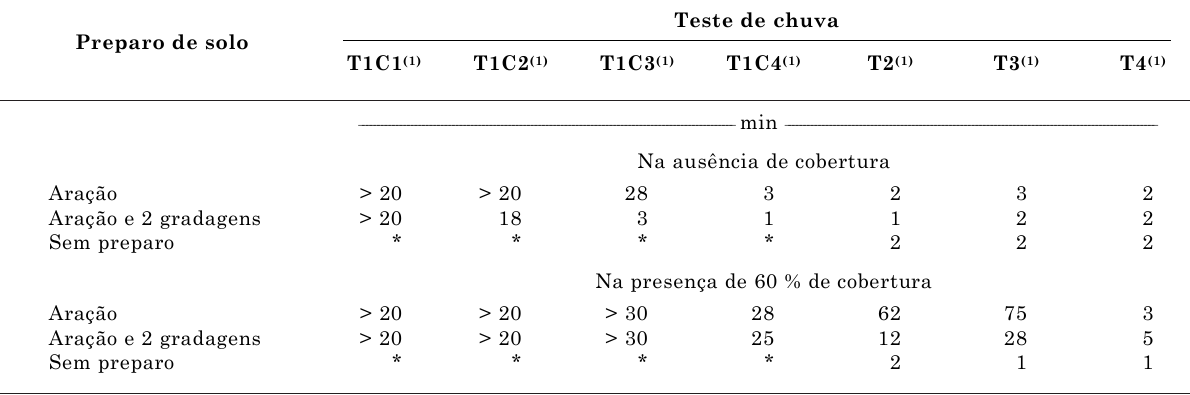
contínuas e tiveram 90 min de duração. * Não realizado o T1 neste tratamento.